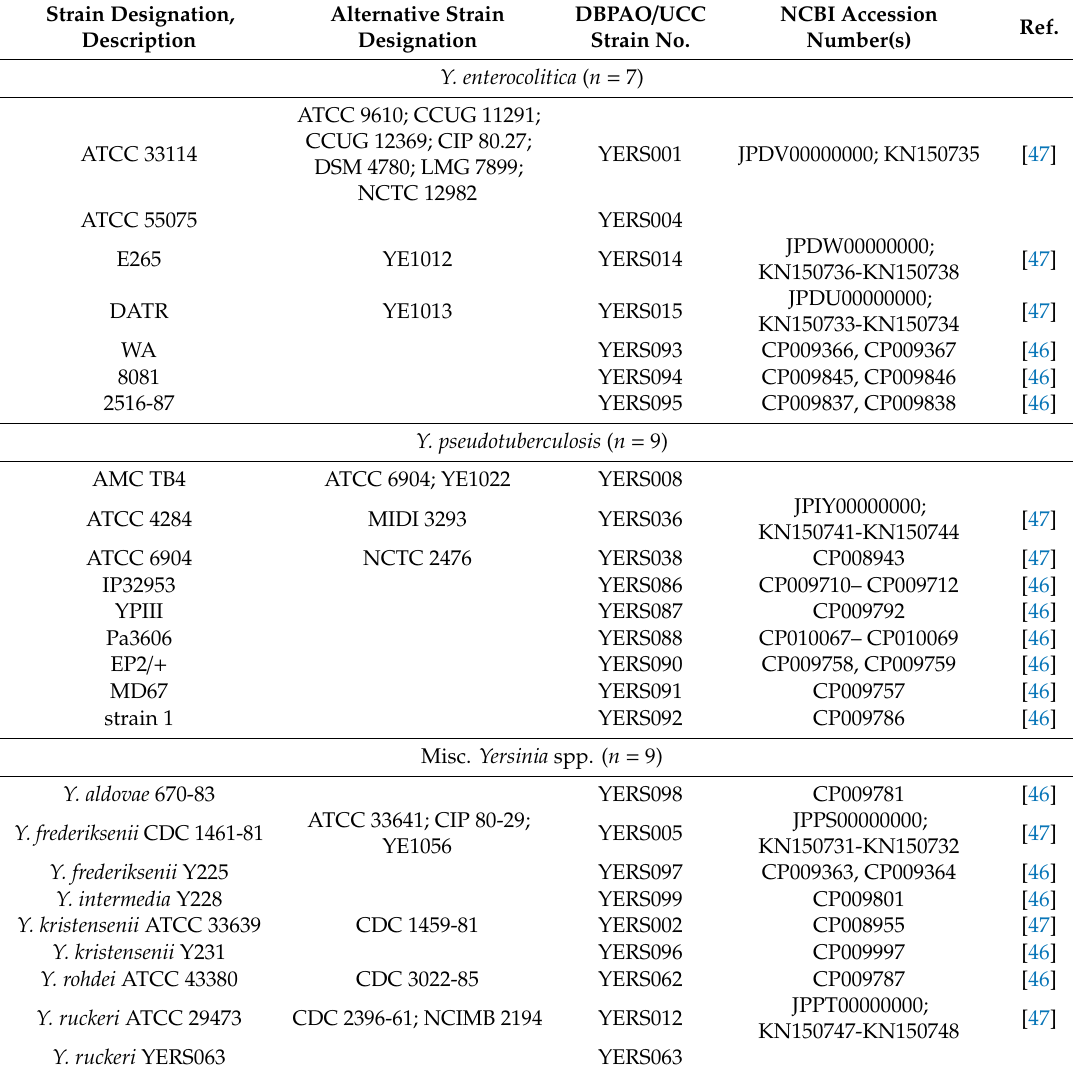
Table 11. Other Yersinia spp. strains used in this